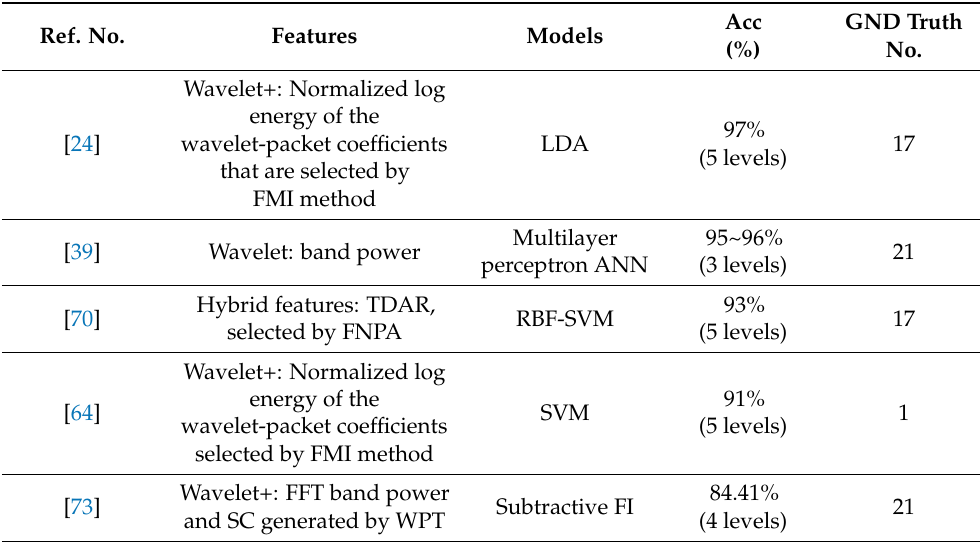
Table 7. EEG-based DDD Accuracies obtained by using Multi-class Classification Models and Various Features and Ground